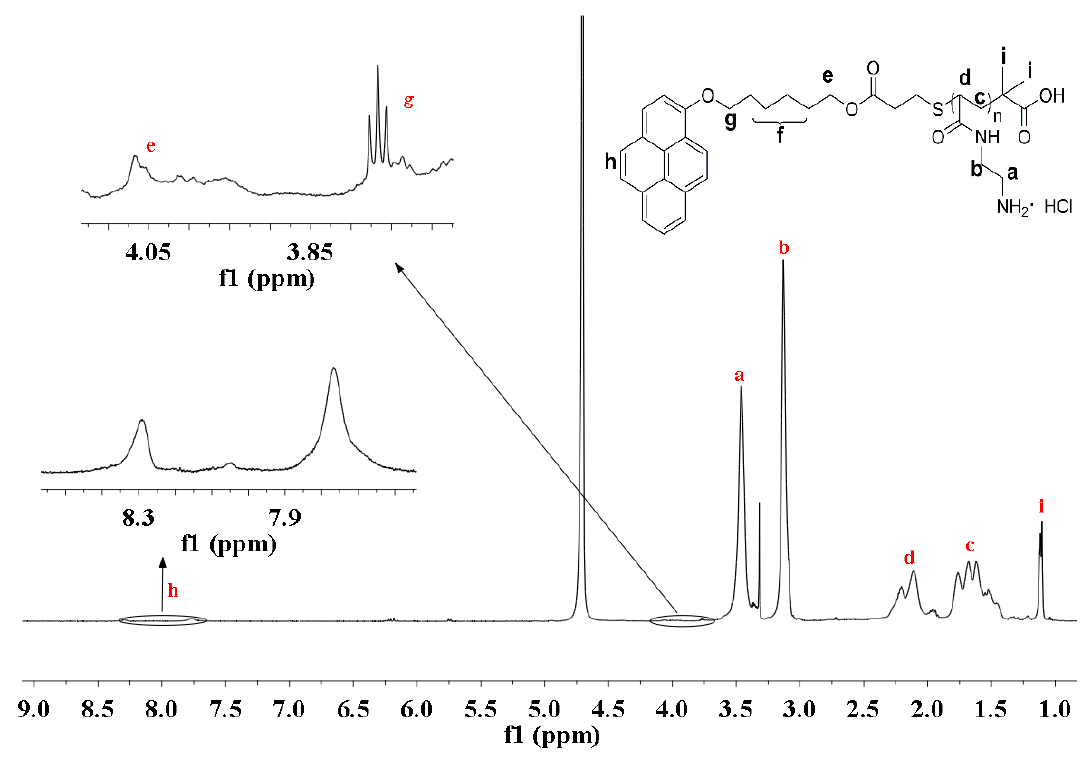
Figure 5. 1 H NMR spectrum of P3 in D 2 O.